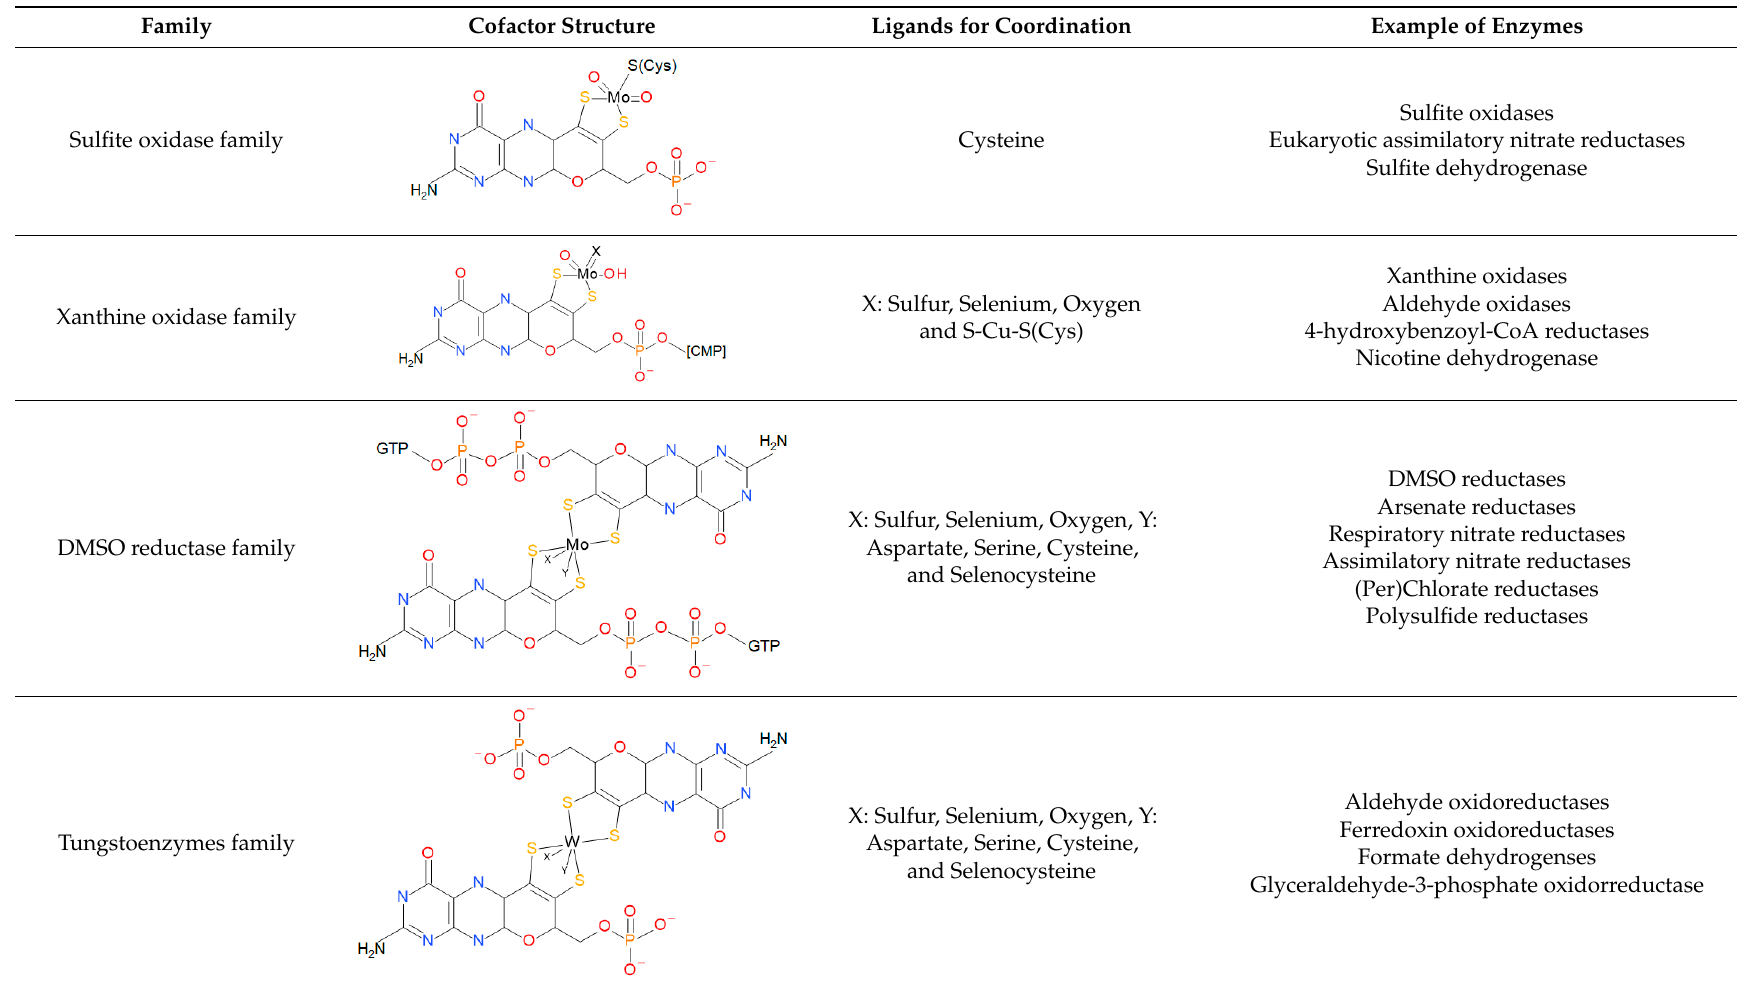
Table 1. Families of enzymes containing molybdenum or tungsten. Molecules drawn with BioVIA Draw 2019 [8].